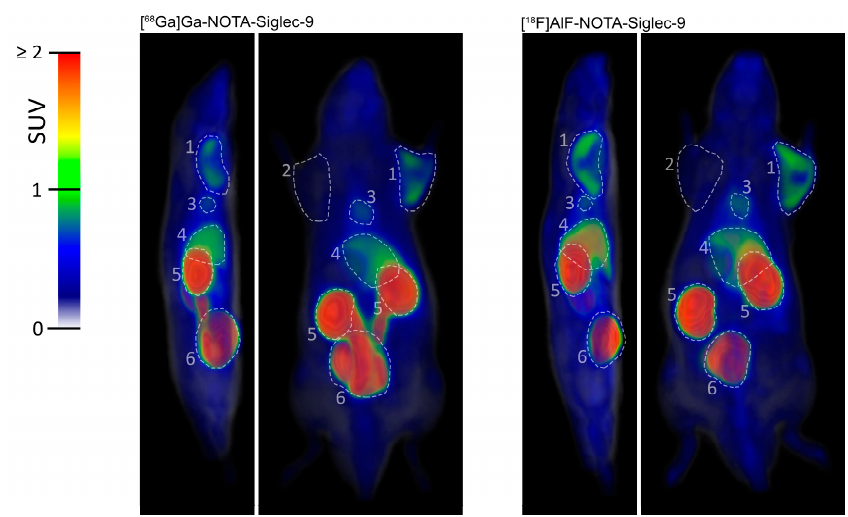
Figure 2. Sagittal ( left panels ) and coronal ( right panels ) maximum intensity projection PET images of [ 68 Ga]Ga- and [ 18 F]AlF-NOTA-Siglec-9 biodistribution in rats. The images are averaged from time frames 10 to 60 min and normalized to the same standardized uptake value (SUV) scale. Highlighted regions of interest: (1) inflamed area; (2) control area; (3) heart; (4) liver; (5) kidneys; and (6) urinary bladder.